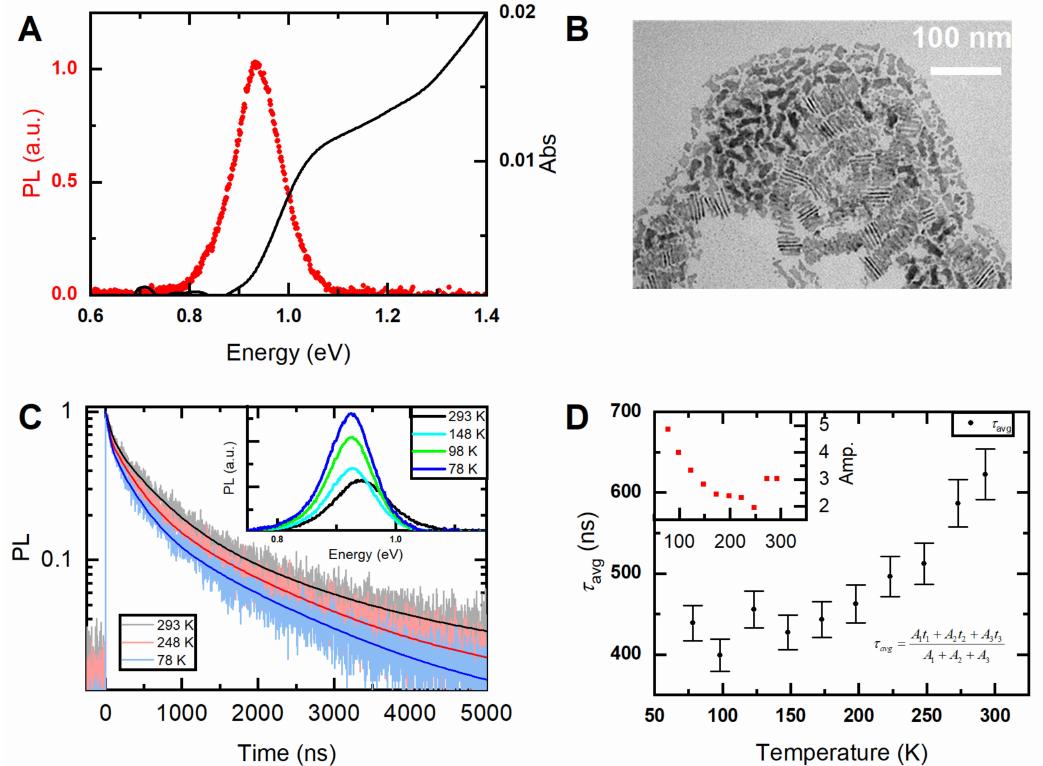
Figure 1. ( A ) Absorption (black line) and photoluminescence (PL) (red dots) spectra of four monolayered (ML) PbSe nanoplatelets (NPLs) in tetrachloroethylene; ( B ) transmission electron microscopy (TEM) image of 4 ML PbSe NPLs ( C ) PL decay curves recorded at di ff erent temperatures, inset—PL spectra obtained in 78–300 K temperature range ( D ) averaged PL decay times vs. temperature, inset—integrated PL intensity vs.